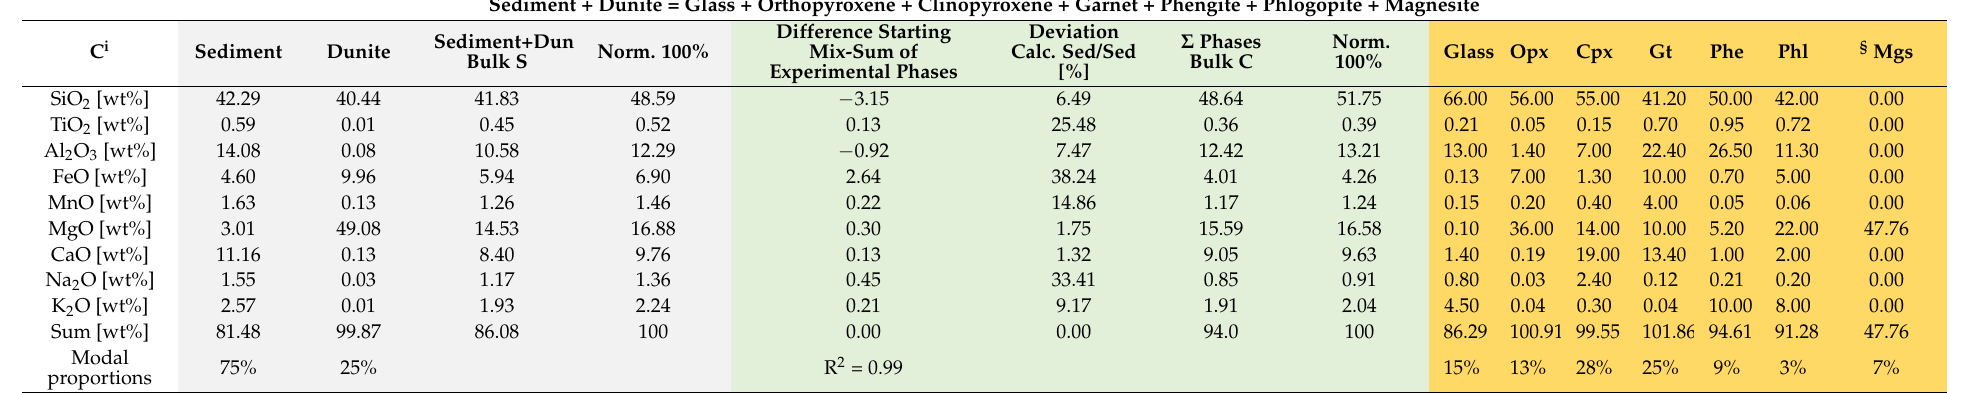
Table A3. This table shows the mass balance of experiment 4 (3 GPa/850 ◦ C) using the average phase compositions from Table 2. Modes of measured glass and crystalline phases of the experiments (yellow box) are calculated (green box) and compared to the starting composition (grey